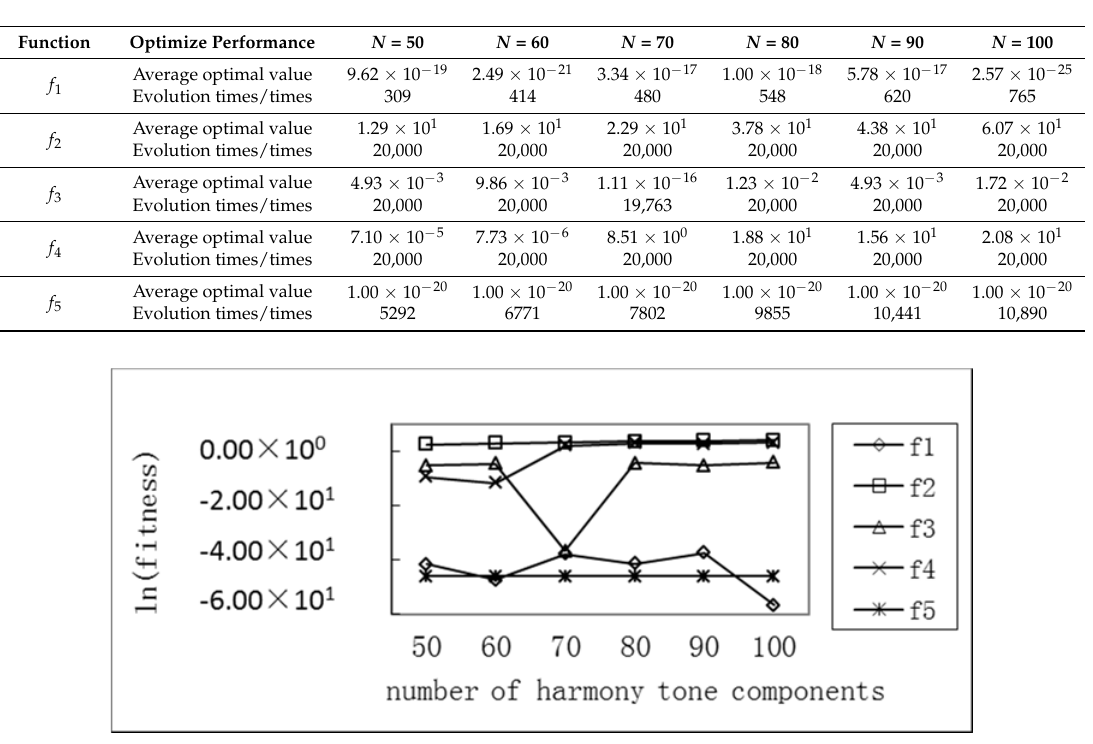
Figure 12. Comparison of the average optimum with different harmony tone components of five functions.